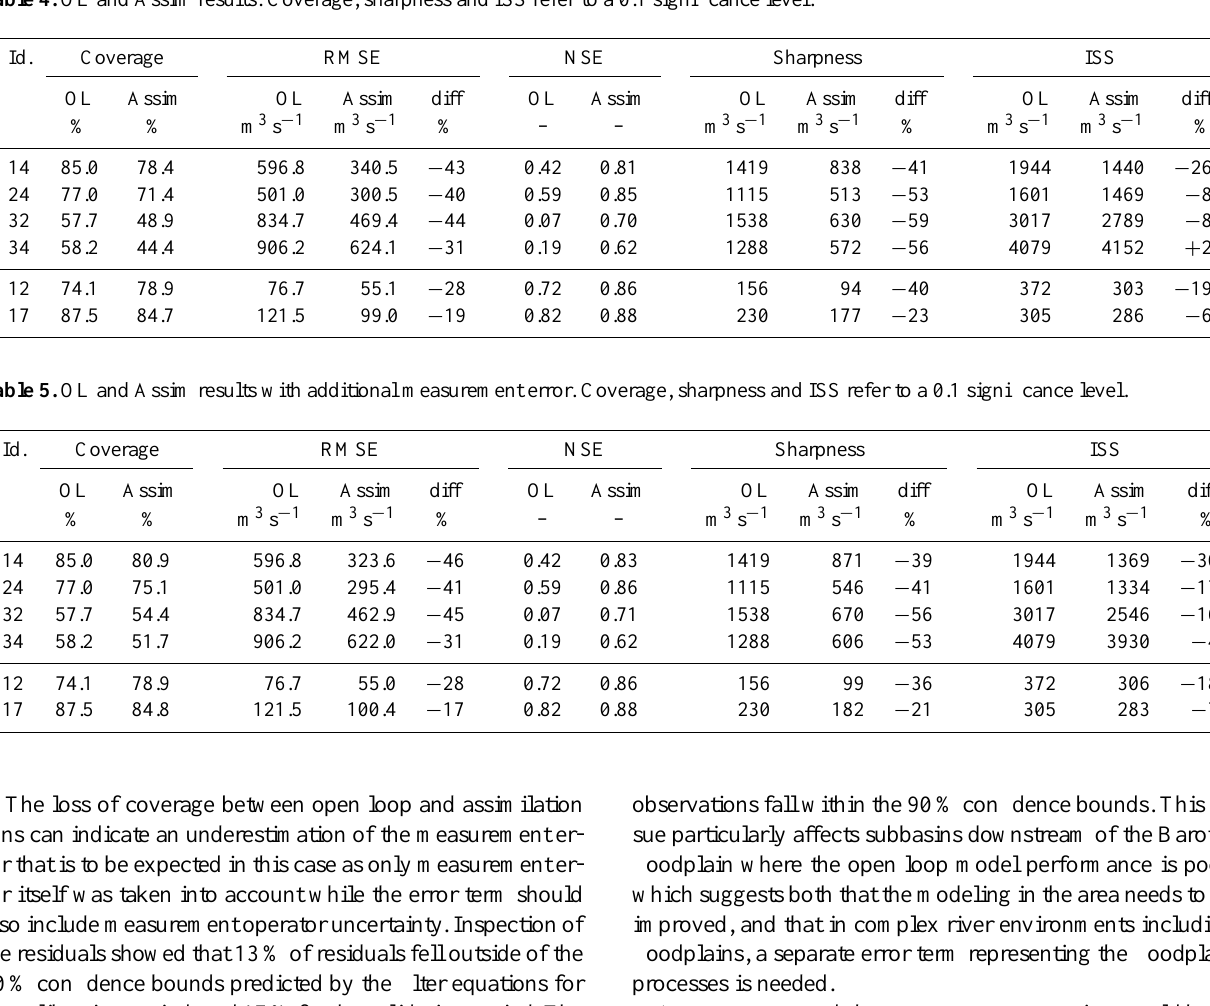
Table 4. OL and Assim results. Coverage, sharpness and ISS refer to a 0.1 significance level.